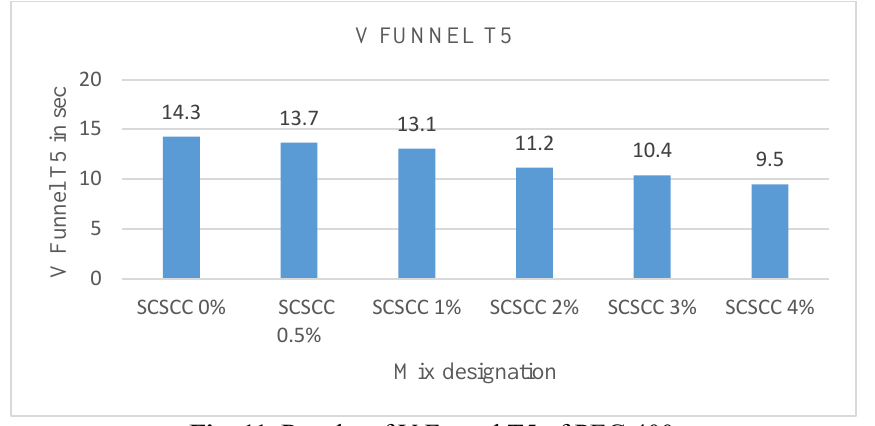
Fig. 11. Results of V Funnel T5 of PEG 400.